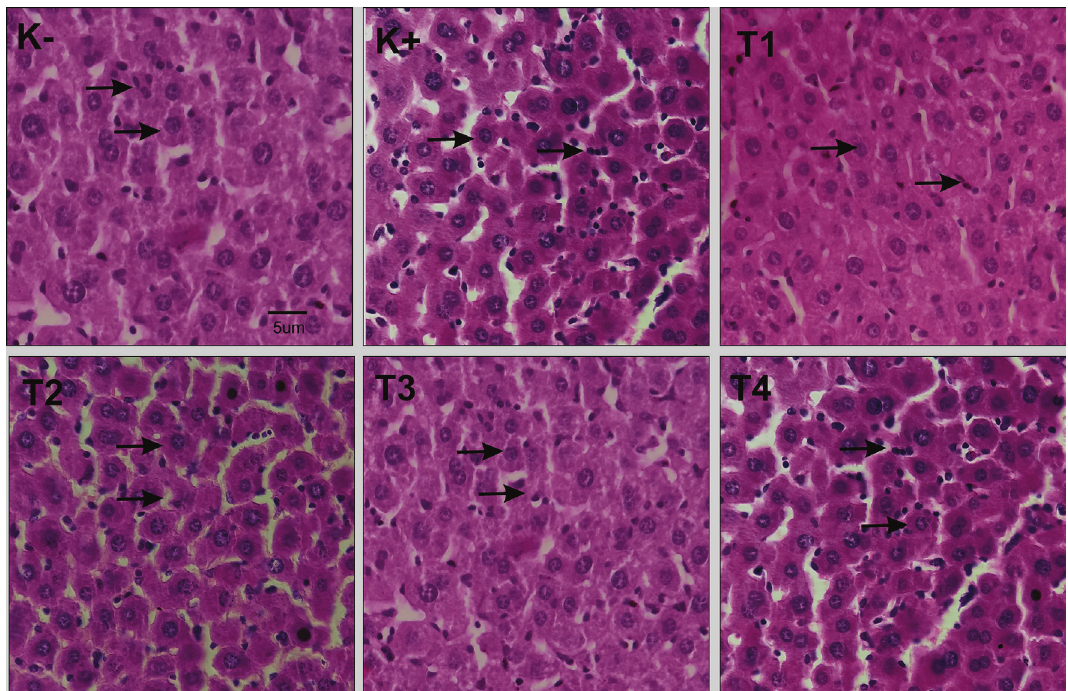
FIGURE 1 - Normal and necrosis cell liver, staining using Hematoxylin-Eosin. Arrow = necrosis cell and normal cell (400 X magnification).